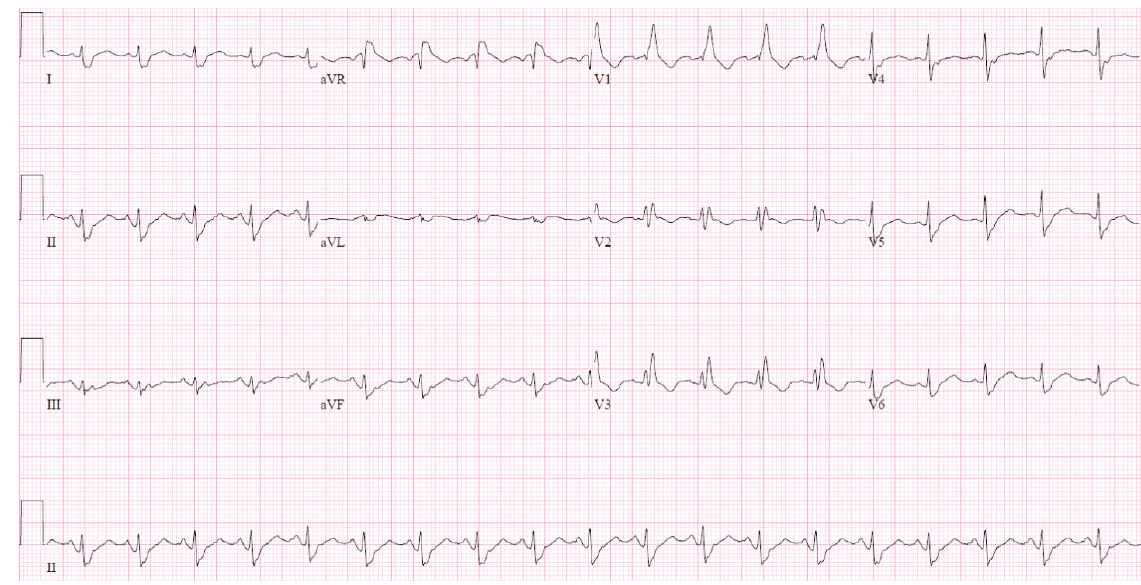
Figure 2: EKG showing sinus tachycardia and right bundle branch